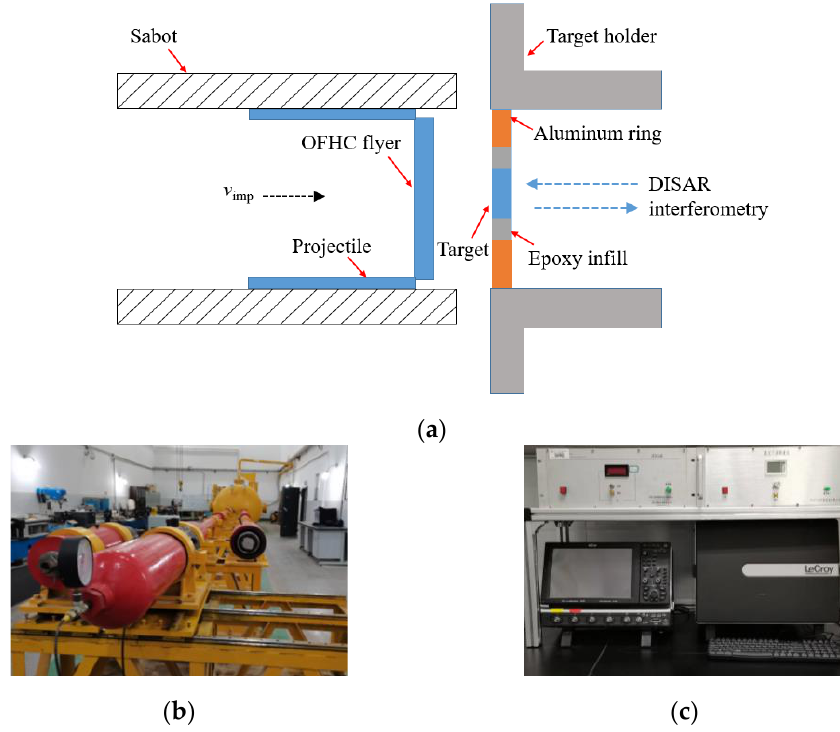
Figure 2. Schematic illustration of the plate impact experiments for the HSLA. ( a ) schematic diagram; ( b ) image of air gun; ( c ) image of